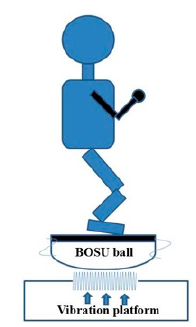
Figure 1. Whole-body vibration and unstable surface training setup and procedure.